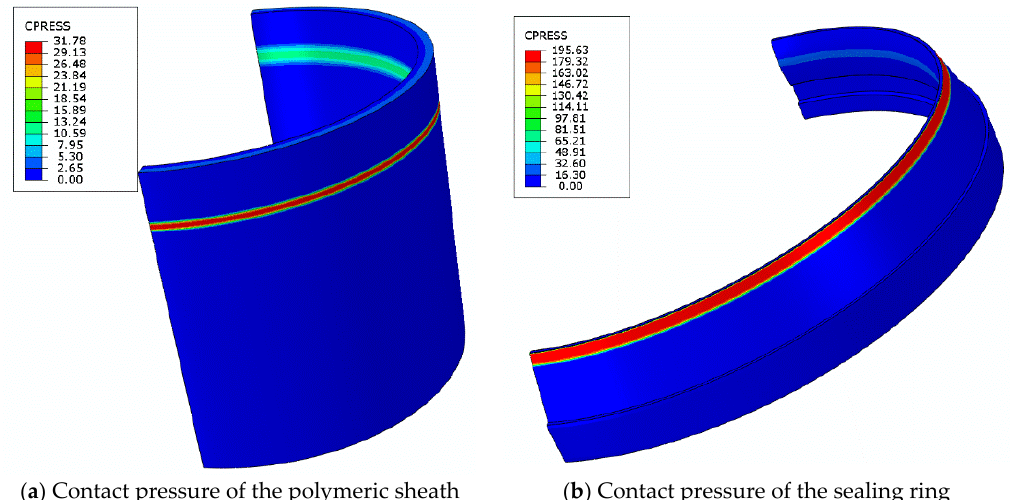
Figure 7. Contact analysis of the sealing structure.